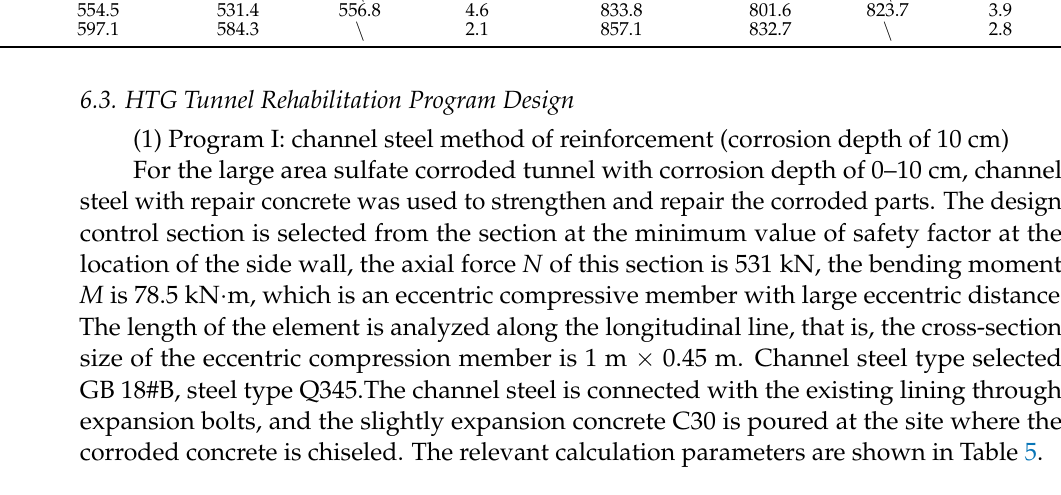
Table 5. Calculation parameters of reinforcement scheme by channel steel